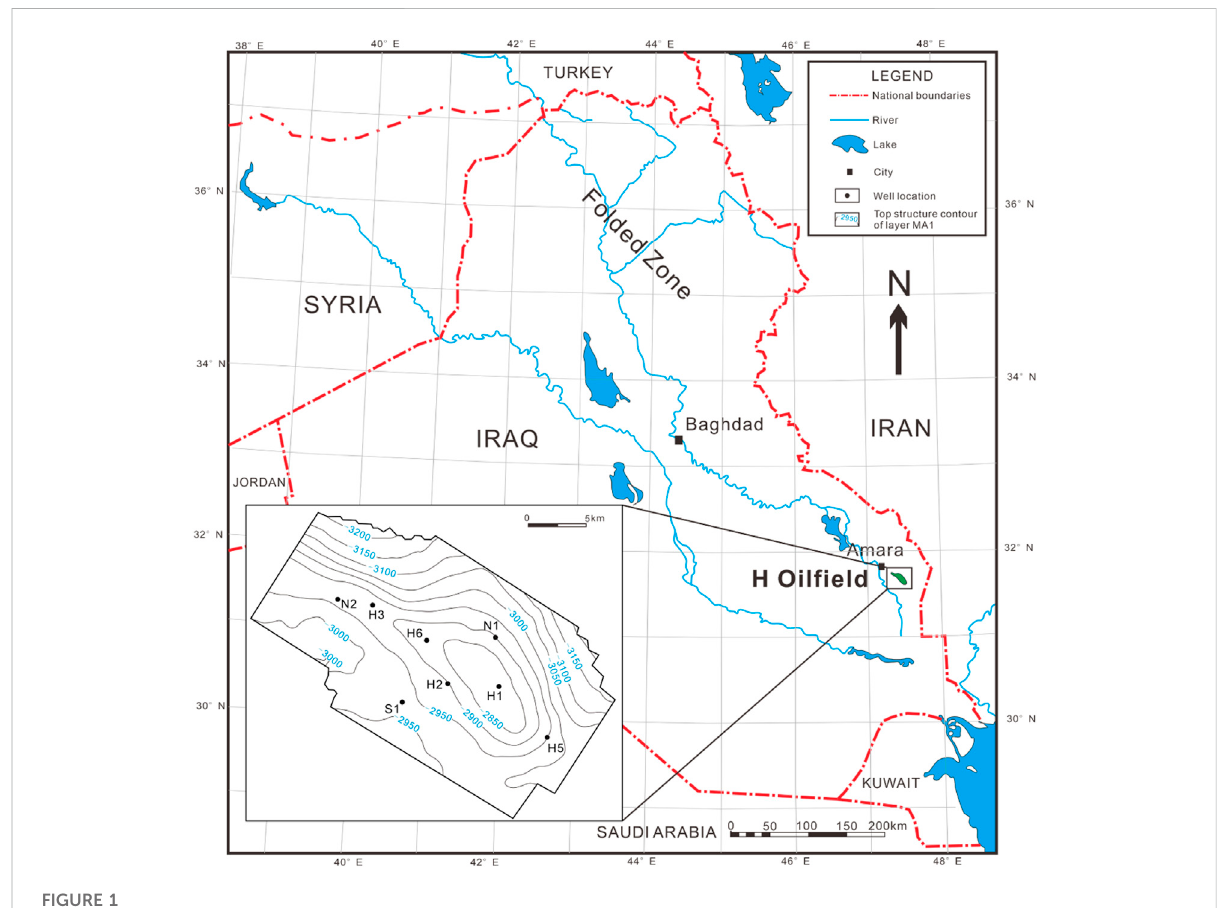
FIGURE 1 Geographical location of the H oil fi eld (after Fouad,